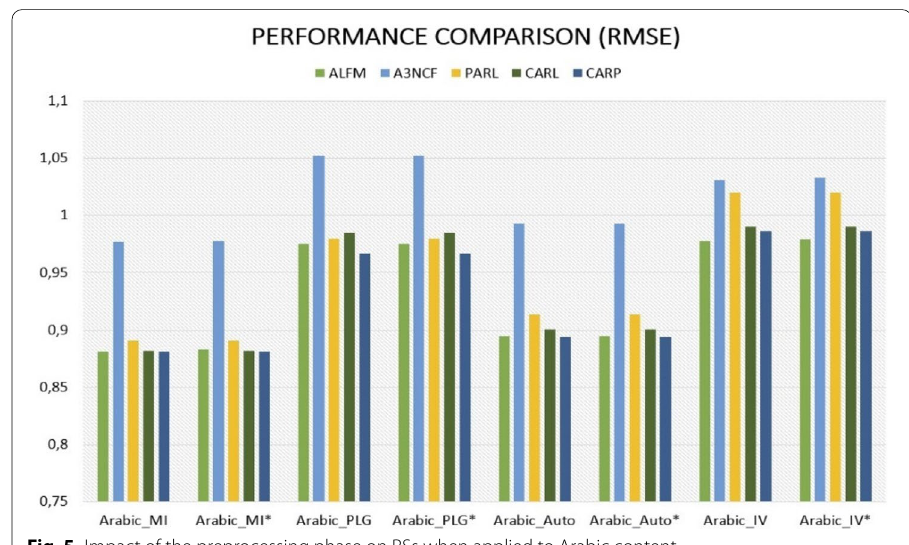
Fig. 5 Impact of the preprocessing phase on RSs when applied to Arabic